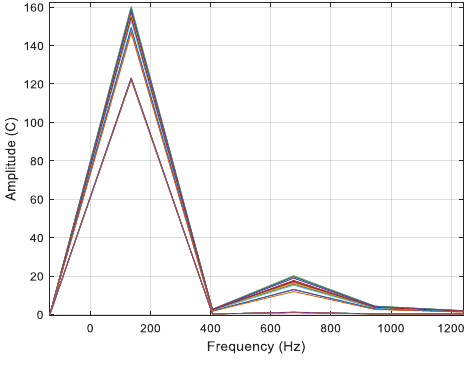
Figure 13. Zoom of Figure 12.